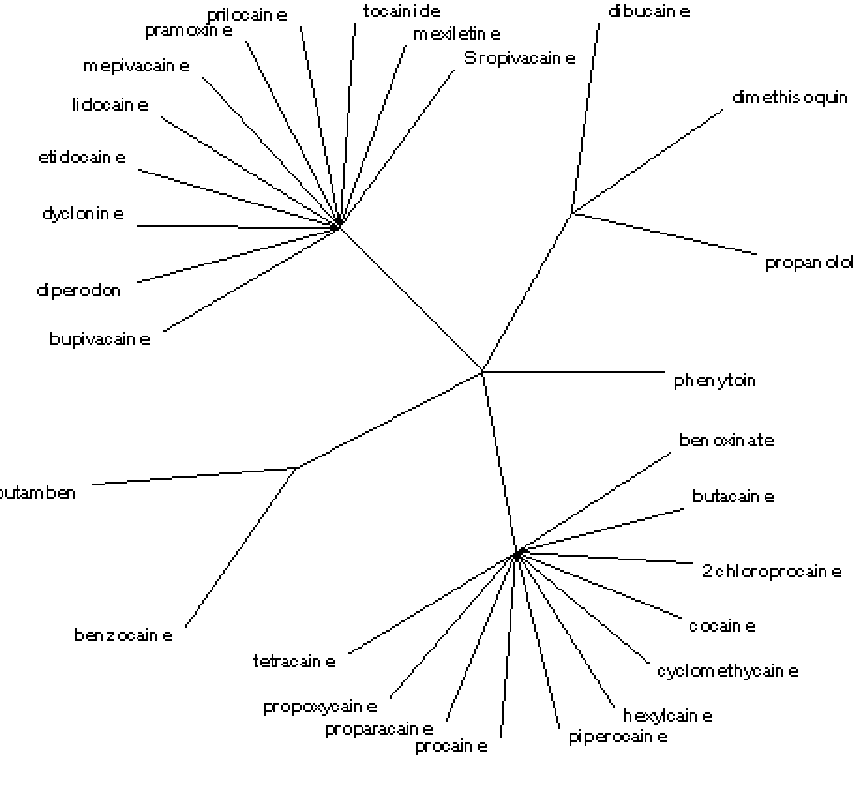
Figure 4. Radial tree for the local anaesthetics analogues of procaine at level b